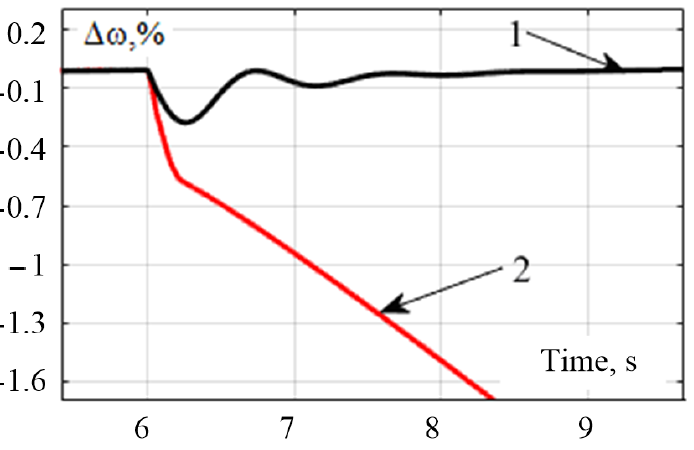
Figure 11. Waveforms of the turbogenerator rotor speed deviation when additional load was con- nected: 1 — linear load; 2 — non-linear load.